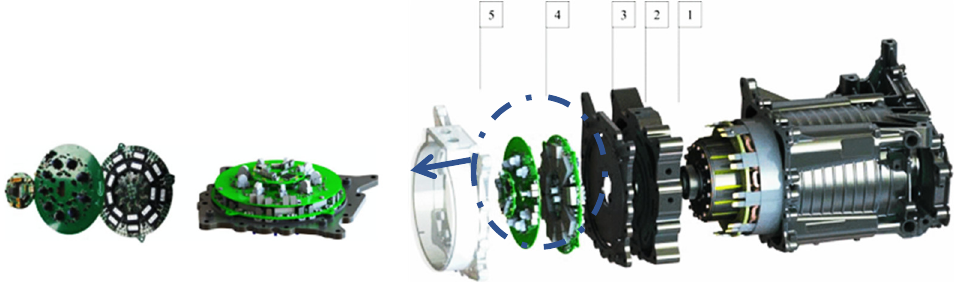
Figure 32. Nine-phase drivetrain for EV applications. (1) Motor housing, (2) Stator, (3) Ferrite motor, (4) Bearing shield-inverter base plate, and (5) Inverter [173].